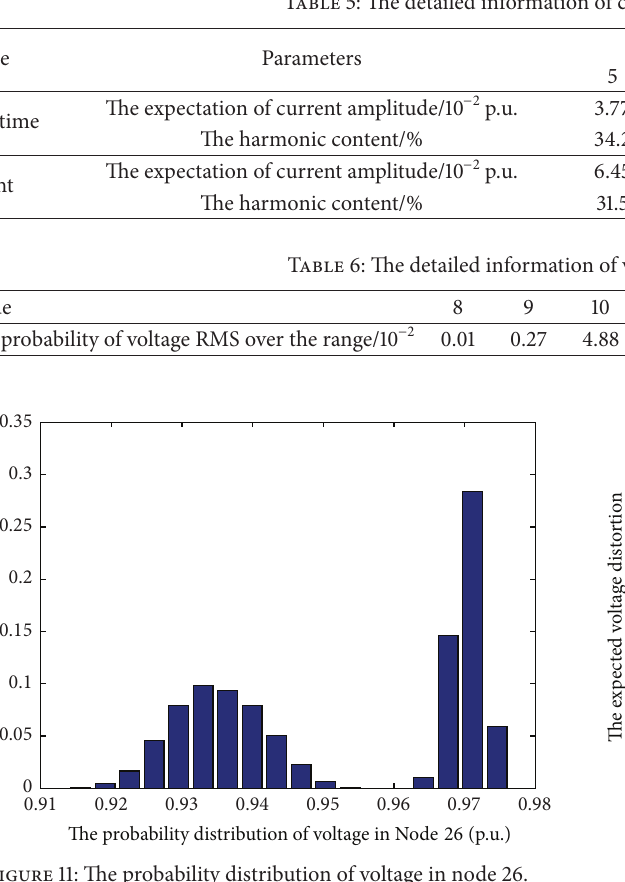
Figure 12: The expected voltage distortion of each node.